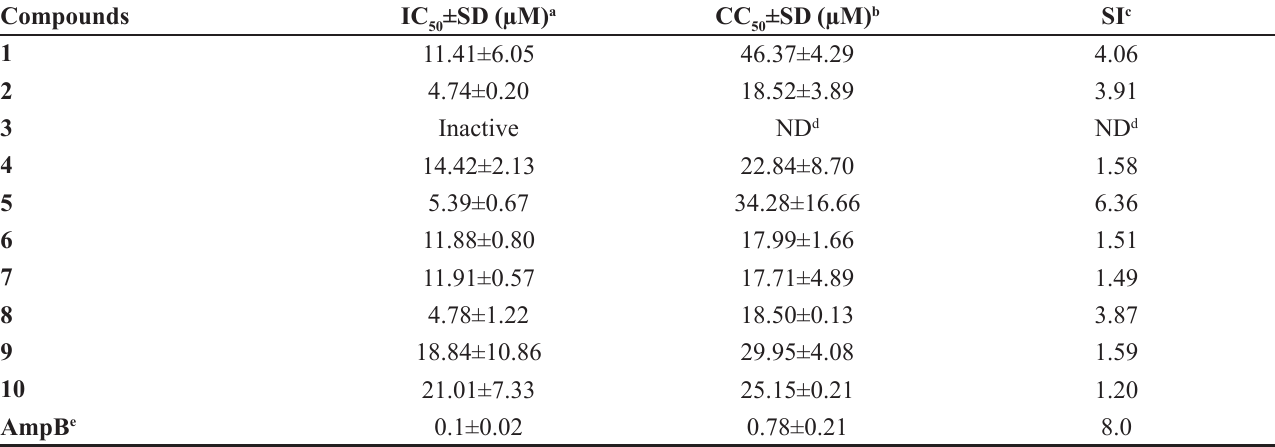
), cytotoxicity profile (CC 50